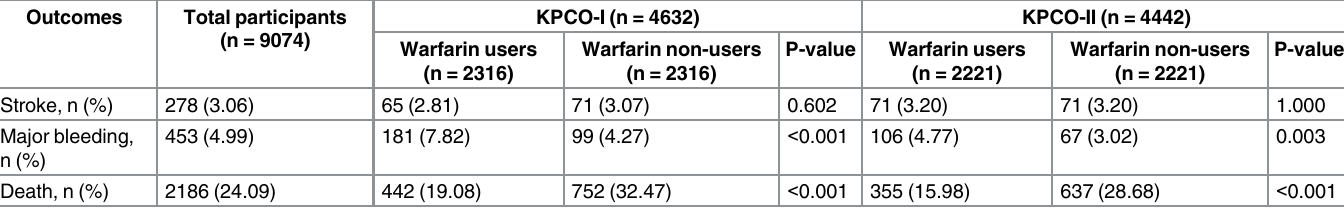
Table 3. Outcomes until study outcome end date between warfarin users and non-users in KPCO-I and KPCO-II cohorts.